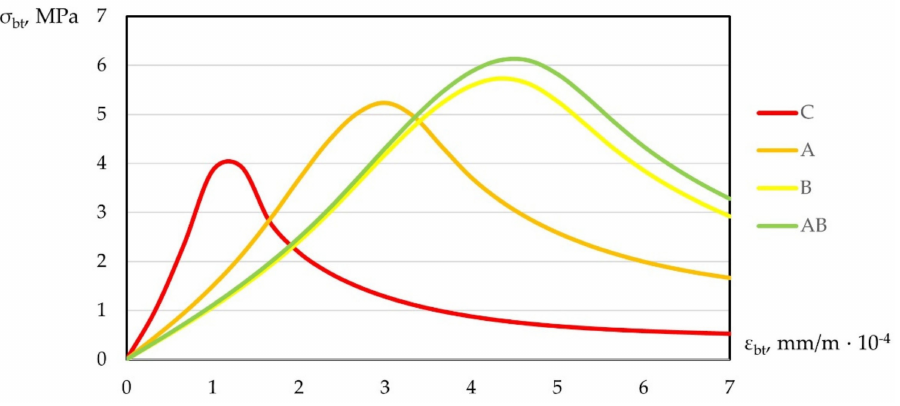
Figure 12. Diagram of “stress–strain” under